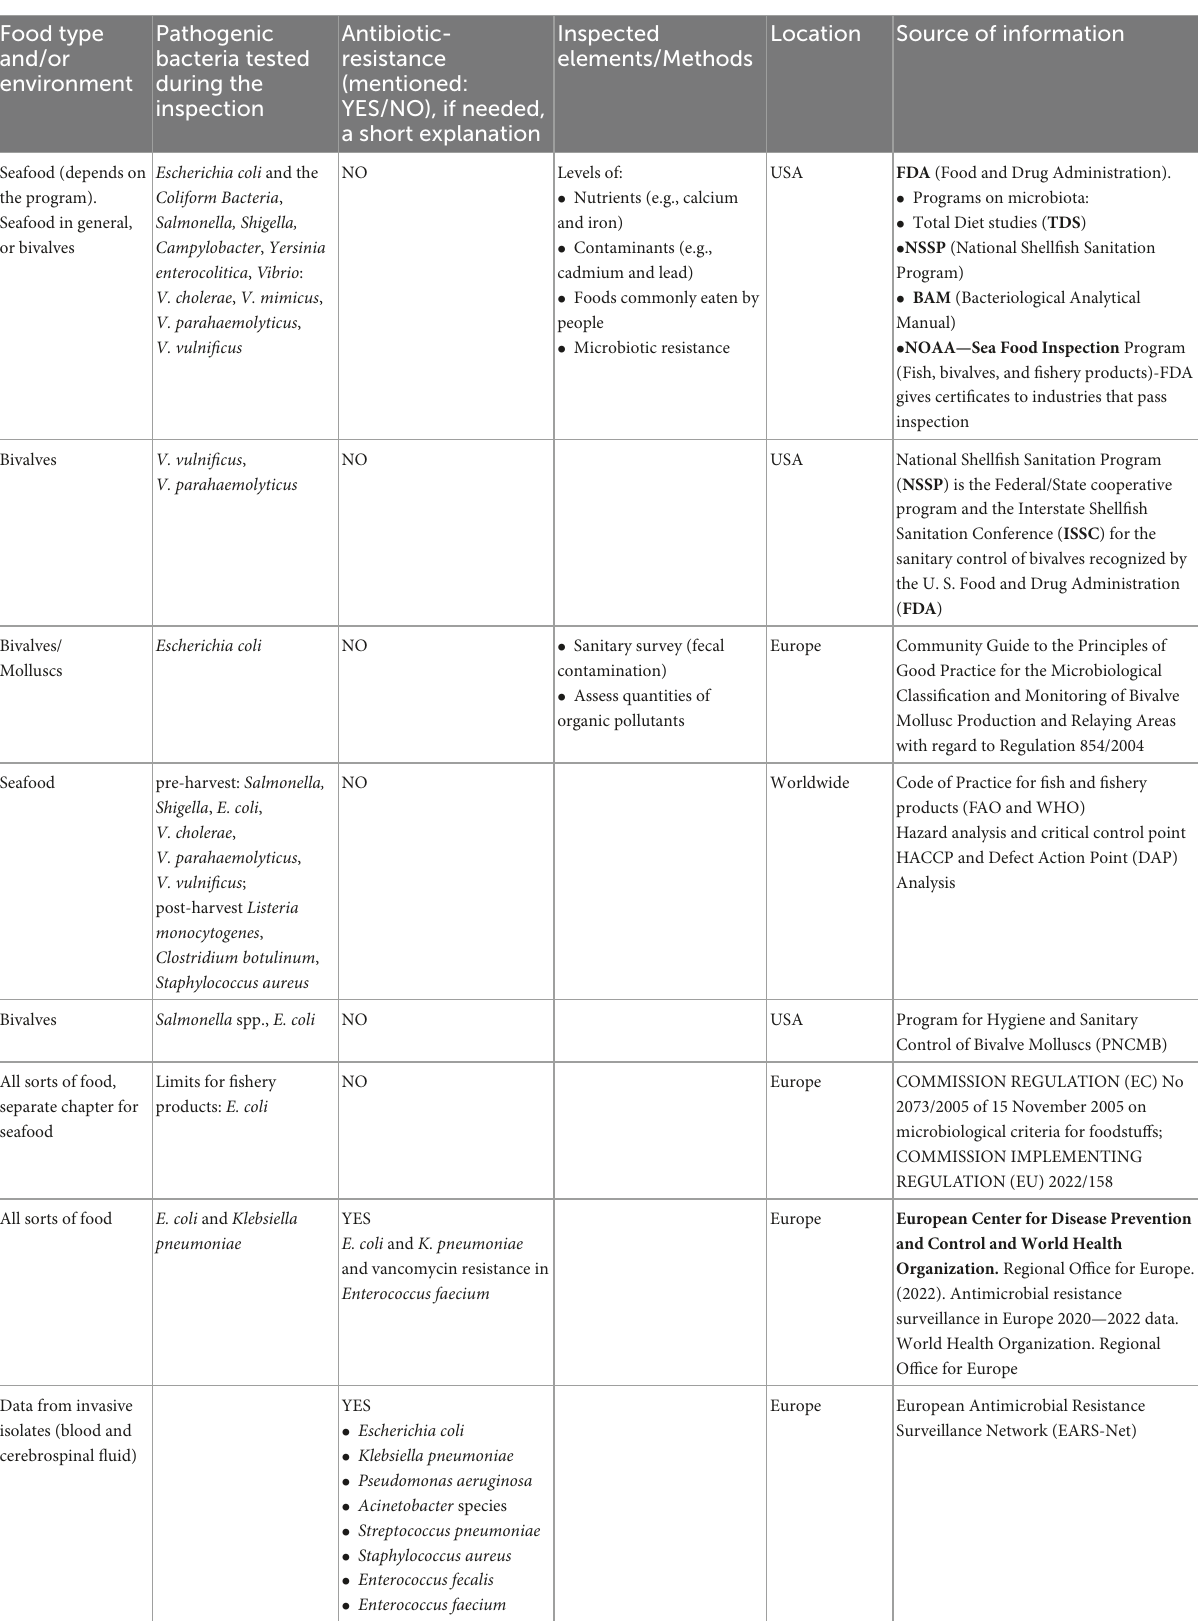
TABLE 1 Official seafood monitoring sanitary